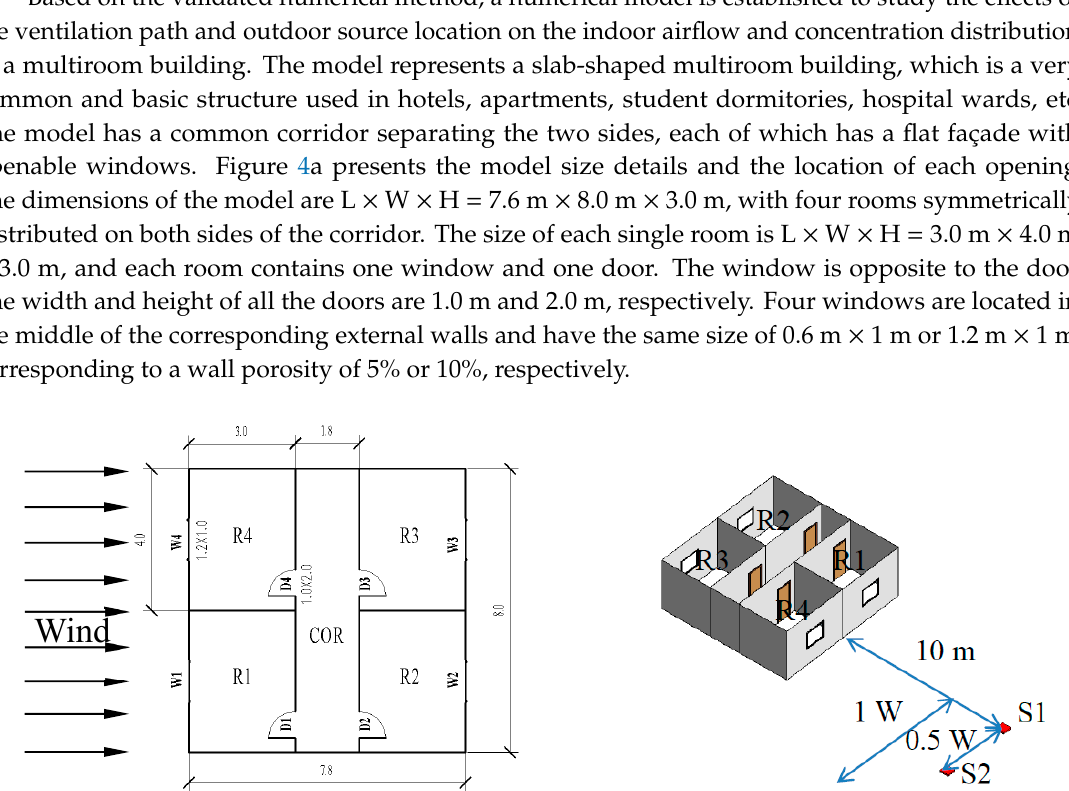
( b ) Figure 5. ( a ) The overall grid schematic diagram (top view); ( b ) Local grid schematic diagram of the building surface.